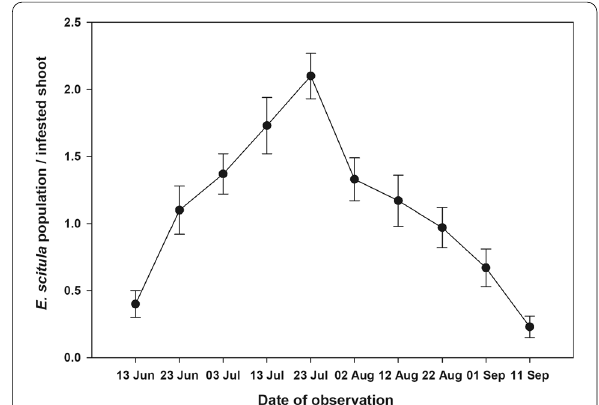
Fig. 3 Field abundance of Eublemma scitula on C. cirripediformis infesting C. diurnum plants (mean 2021